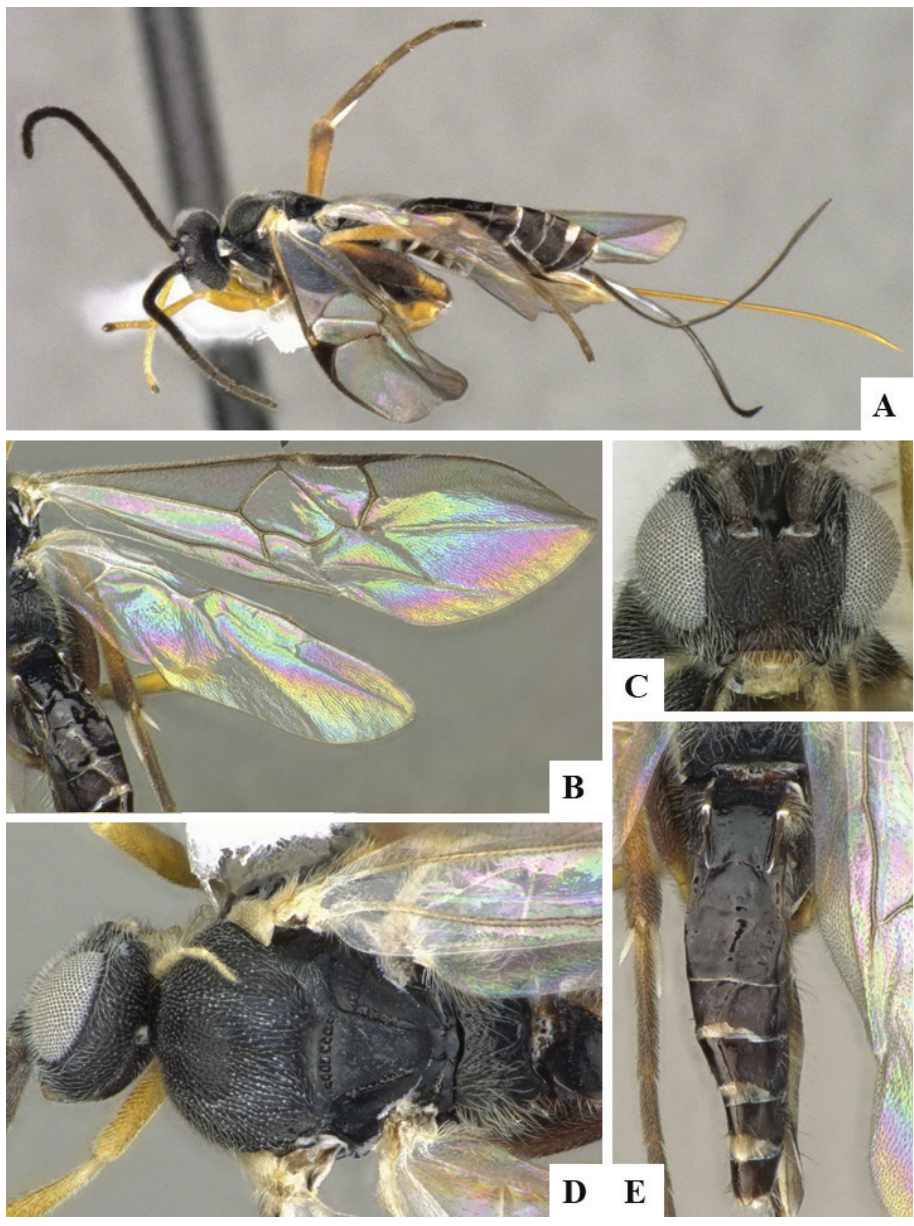
Figure 1. A–E Dolichogenidea alejandromasisi sp. n., holotype. A habitus, lateral B wings C head, fron- tal D head and mesosoma, dorsal E metasoma, dorsal.